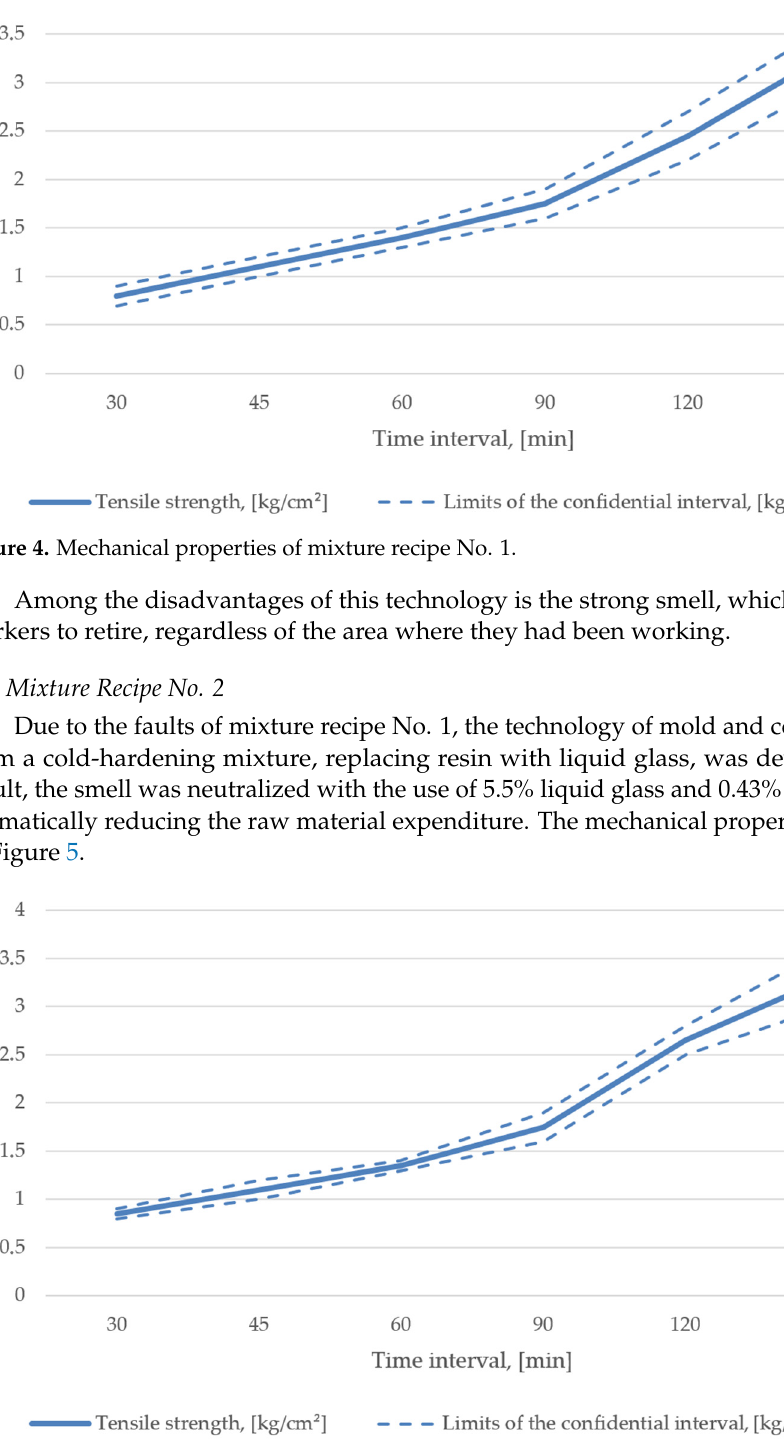
Figure 6. Sand grain micro-specimen from the used liquid glass mixture exposed to long-term out- door storage. S.S. Zhukovskiy proved [33,40] that with long-term exposure to precipitation at pos- itive temperatures, liquid glass film reacts to water, with part of it dissolving to form dif- ferent kinds of hydrated metasilicate crystals, including Na 2 SiO 3 *5H 2 O, Na 2 SiO 3 *6H 2 O, Na 2 SiO 3 *8H 2 O, and Na 2 SiO 3 *9H 2 O. In the used mixture, which had been disposed of for 8–10 years, these processes resulted in the collapse of almost all of its monolith pieces. Nevertheless, as mentioned above, the reclaimed product’s use in the traditional liq- uid glass mixture did not bring any positive result. Therefore, the next research stage was intended to develop a technology for the regeneration of a used liquid glass mixture, ex- posed to long-term outdoor storage.